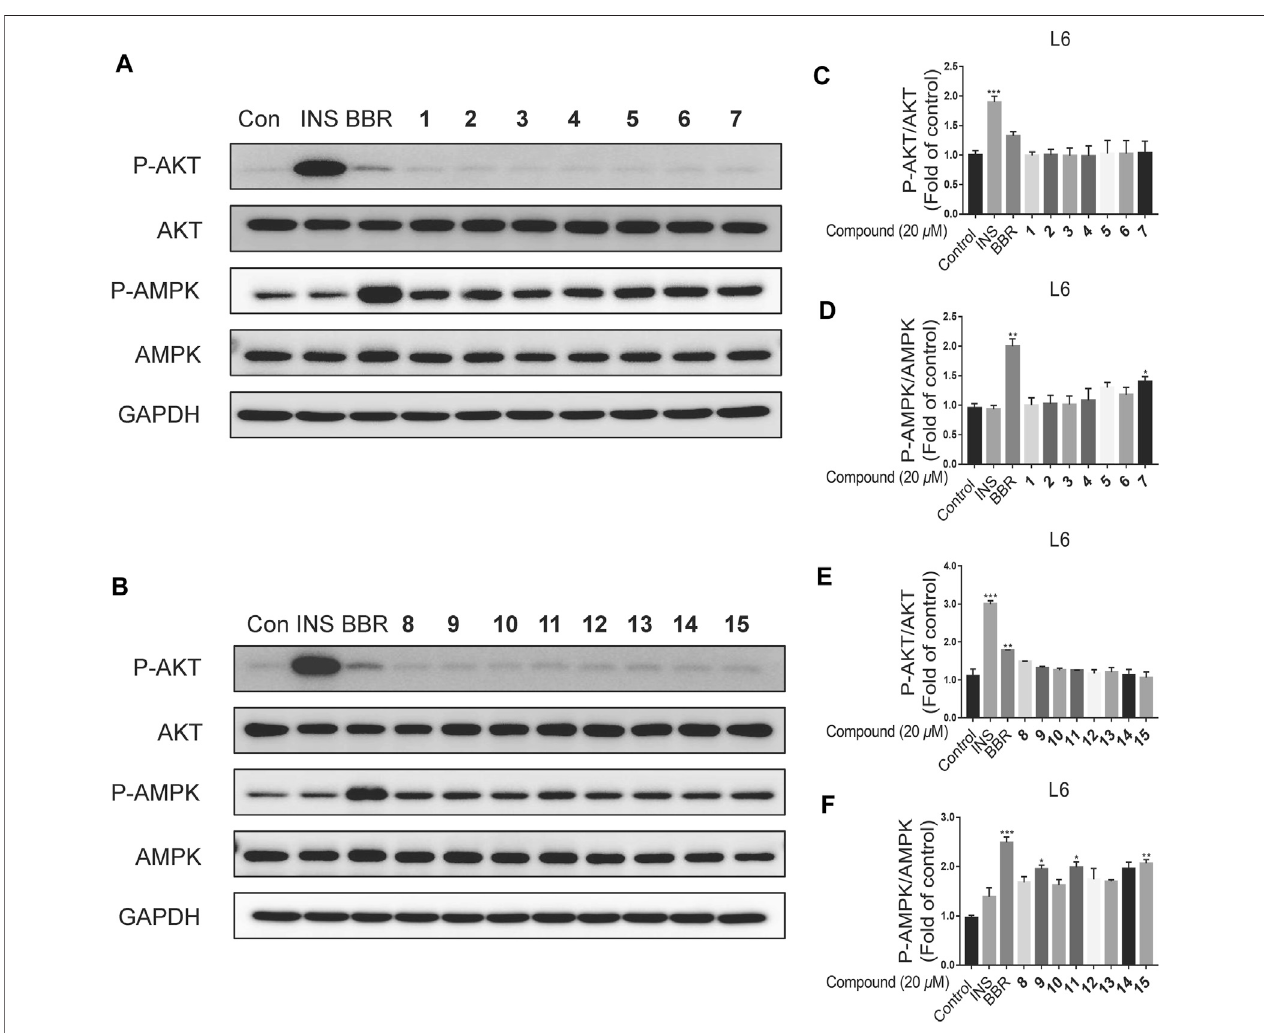
FIGURE 8 | The effects of compounds on L6 myotubes. (A – F) : L6 myotubes were treated with vehicle or 20 μ M compounds or 10 μ M BBR for 24 h ( n (cid:2) 3). Data are for three replicate experiments. ( n (cid:2) 3) * p < 0.05, ** p < 0.01 *** p < 0.001, one-way ANOVA.